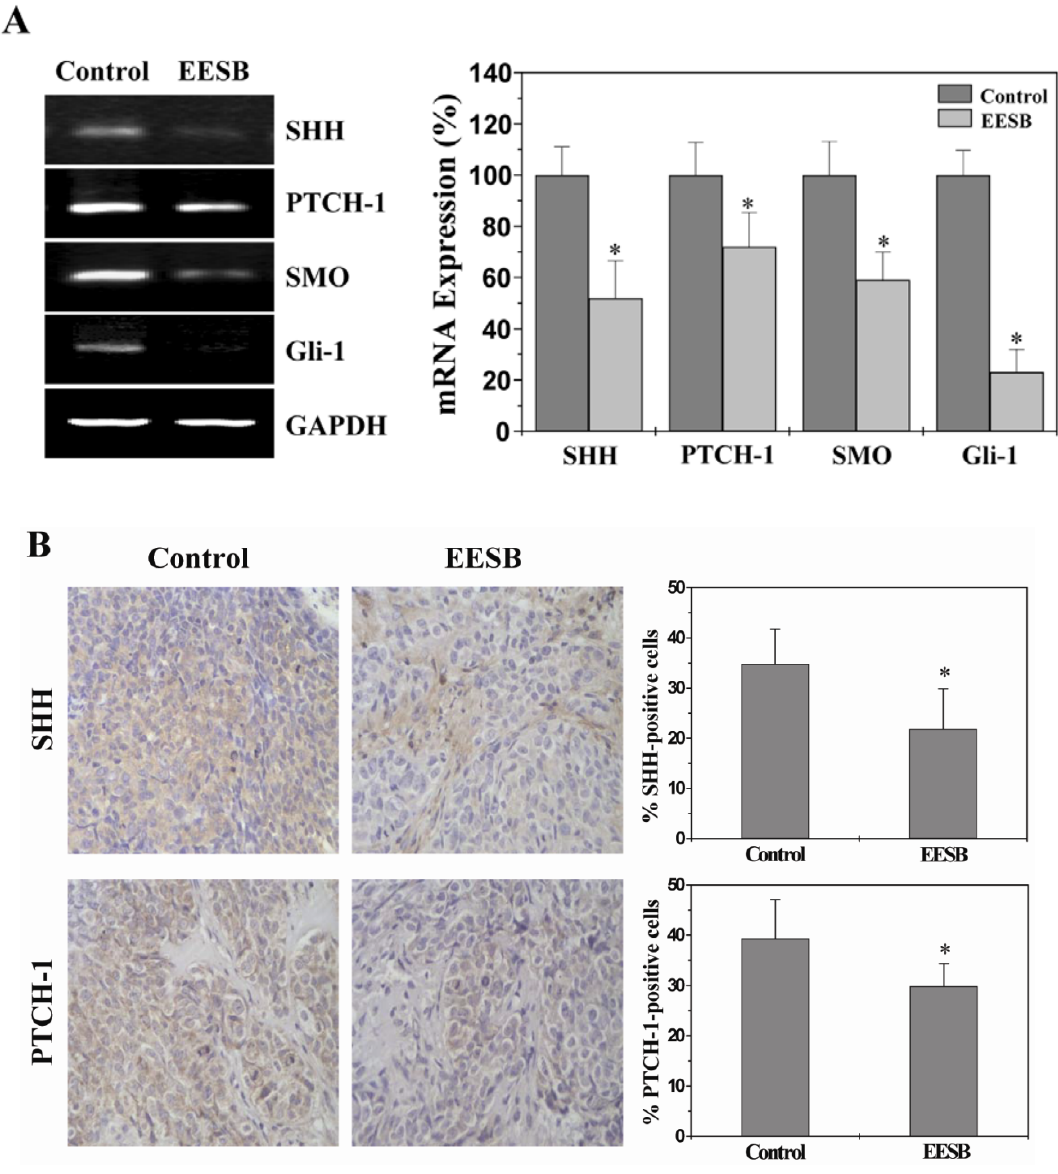
Figure 3. Effect of EESB on the activation of Sonic Hedgehog (SHH) pathway in CRC xenograft mice. ( A ) The mRNA expression levels of SHH, Patched-1 (PTCH-1, smoothened (SMO) and glioma-associated oncogene homolog 1 (Gli-1) were determined by RT-PCR. GAPDH was used as the internal control. The data of densitometric analysis were normalized to the mean mRNA expression of untreated control (100%); ( B ) Tumor tissues were processed for IHC staining for SHH, PTCH-1, SMO and Gli-1. The photographs were representative images taken at a magnification of ×400. Quantification of IHC assay was represented as percentage of positively-stained cells. Data shown were averages with S.D. (error bars) from 10 individual mice in each group. * p < 0.05, versus